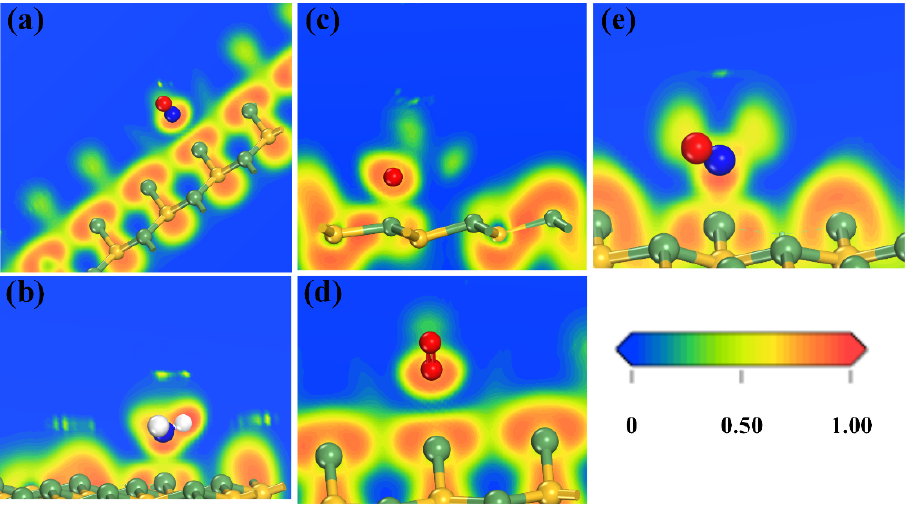
Figure 9. Electron localization function profiles of ( a ) NO-center, ( b ) NH 3 -Ge, ( c ) SO 2 -Si, ( d ) O 2 -center, and ( e ) NO 2 -Ge sites’ adsorptions.